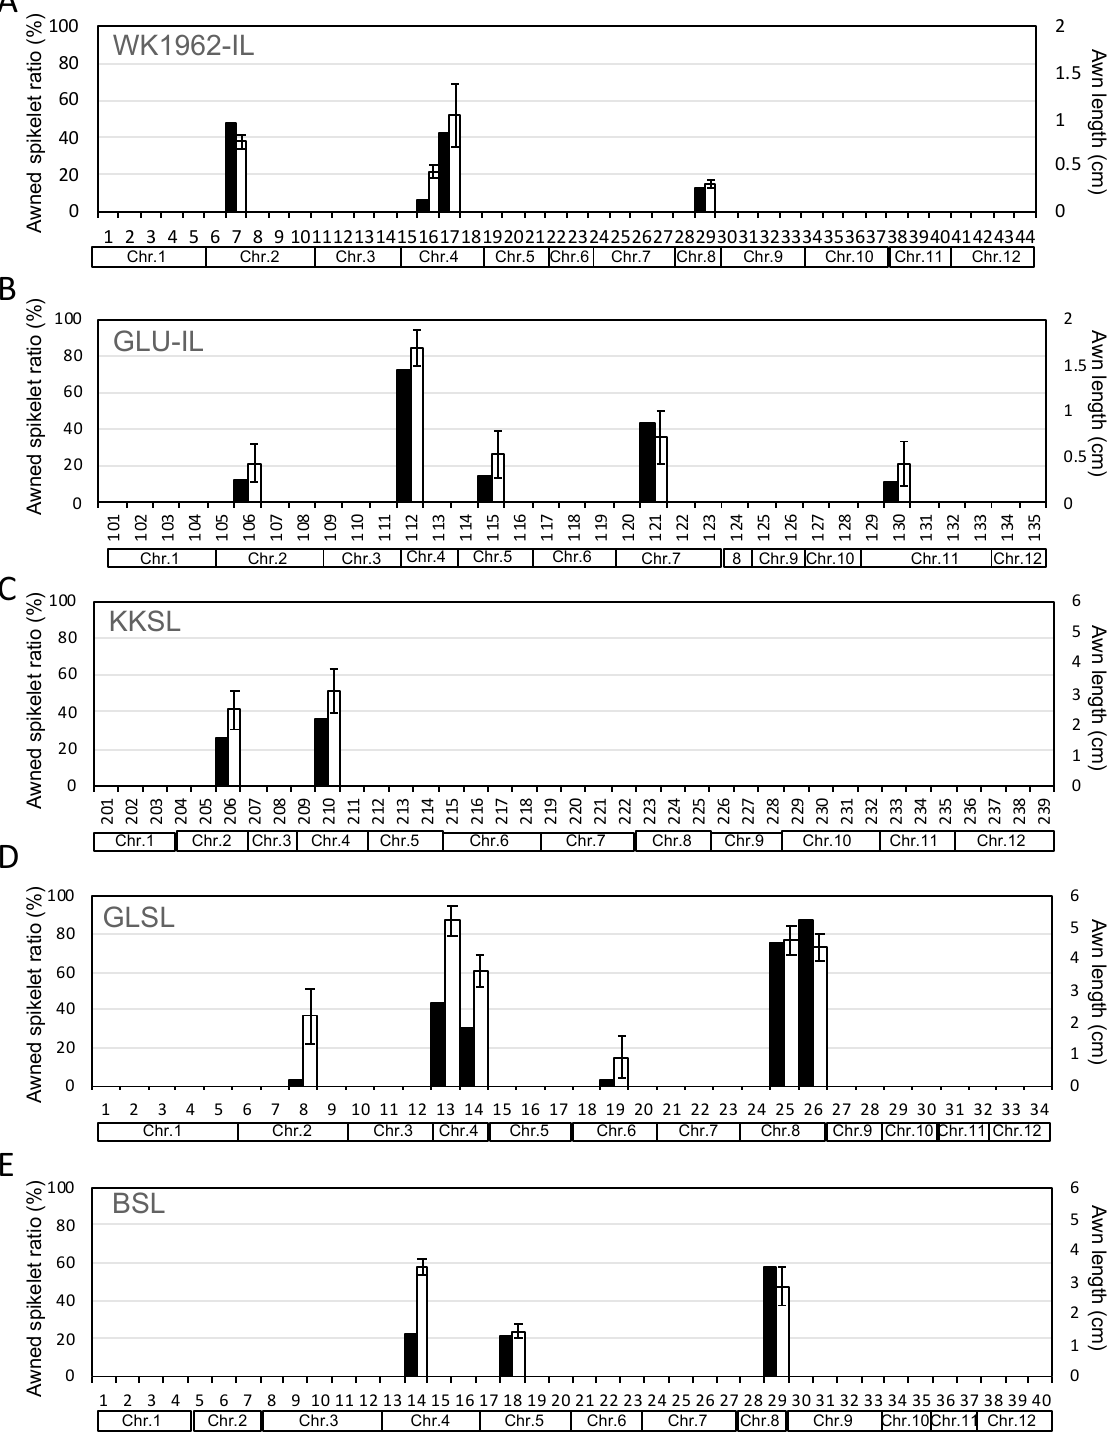
Figure 3. Comparison of awn traits among CSSLs. Awned spikelet ratio per panicle and awn length among CSSLs whose recurrent parent was T65: ( A ) WK1962-IL and ( B ) GLU-IL. ( C – E ) Awned spikelet ratio per panicle and awn length among CSSLs whose recurrent parent was Koshihikari: ( C ) KKSL, ( D ) GLSL, and ( E ) BSL. Awn phenotype data obtained in 2016 was presented. Awn phenotype data in other CSSLs are presented in Supplementary Figure S2. Black bars indicate awned spikelet ratio per panicle; white